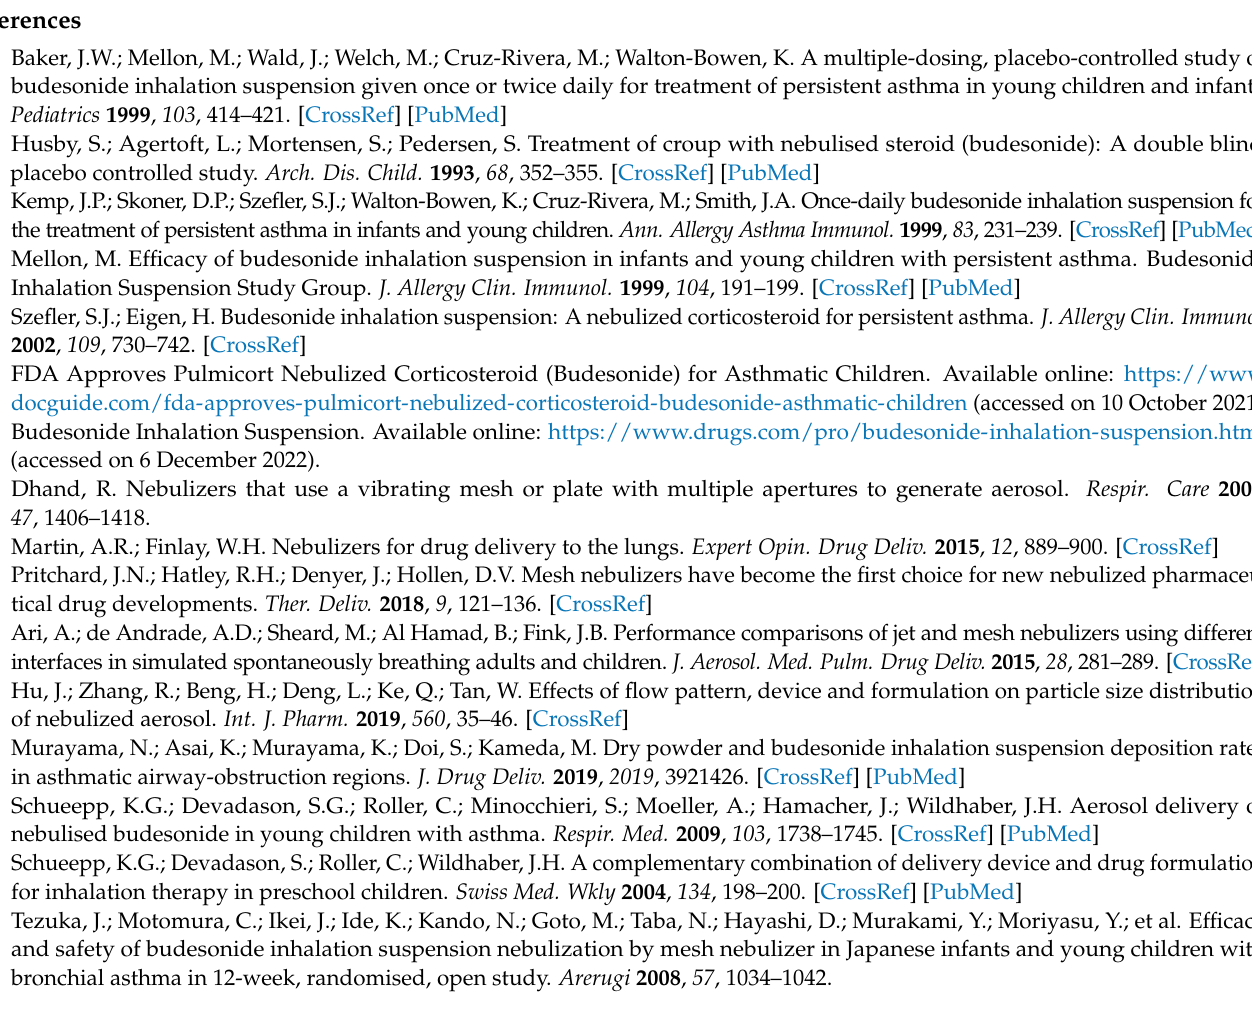
lizer, Table S2: Results of regression analysis, Figure S1: SEM pictures of both sizes of the